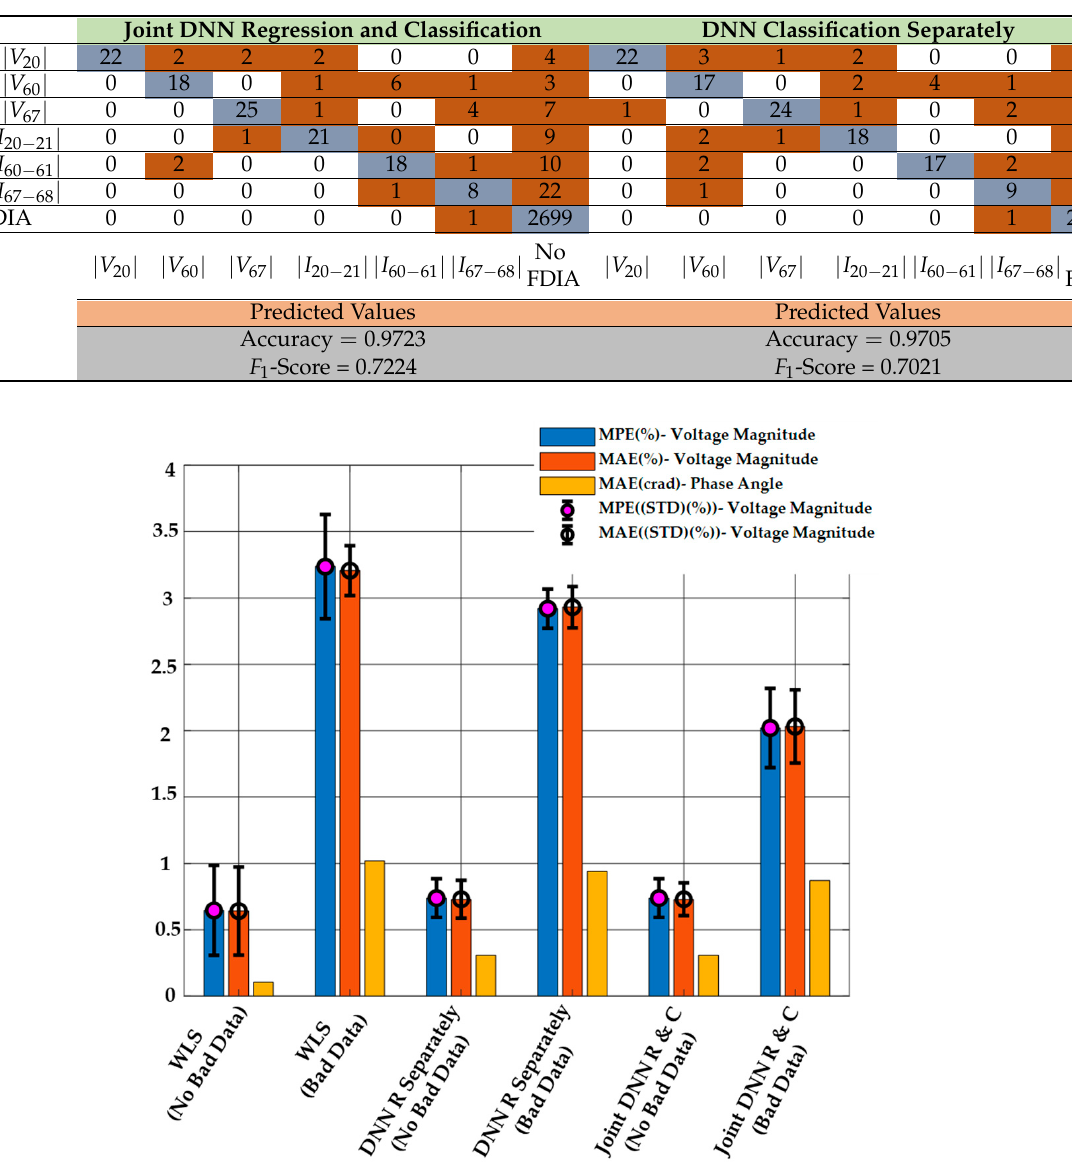
Figure 12. DSSE Results Obtained Using the Proposed Method, the Regression-only DNN Model, and WLS with or without Bad Data when N a = 438 ( 5% ) , and z a = ∼ N ( µ z , σ z ) . Table 7 shows the results for the proposed method and the appropriate binary classifica- tion-only method, where the proposed method successfully detected most FDIAs on each PMU measurement when false data z a = ∼ N ( µ z , σ z ) are injected randomly to 10% of available measurements, and it works better than an independent binary classification method. The accuracy and F 1-score of the proposed method (0.9619 and 0.792, respec- tively) are also better than when performing the binary classification only (0.957 and 0.770,